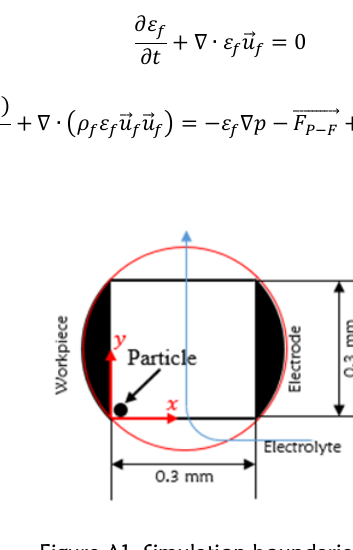
Figure A1. Simulation